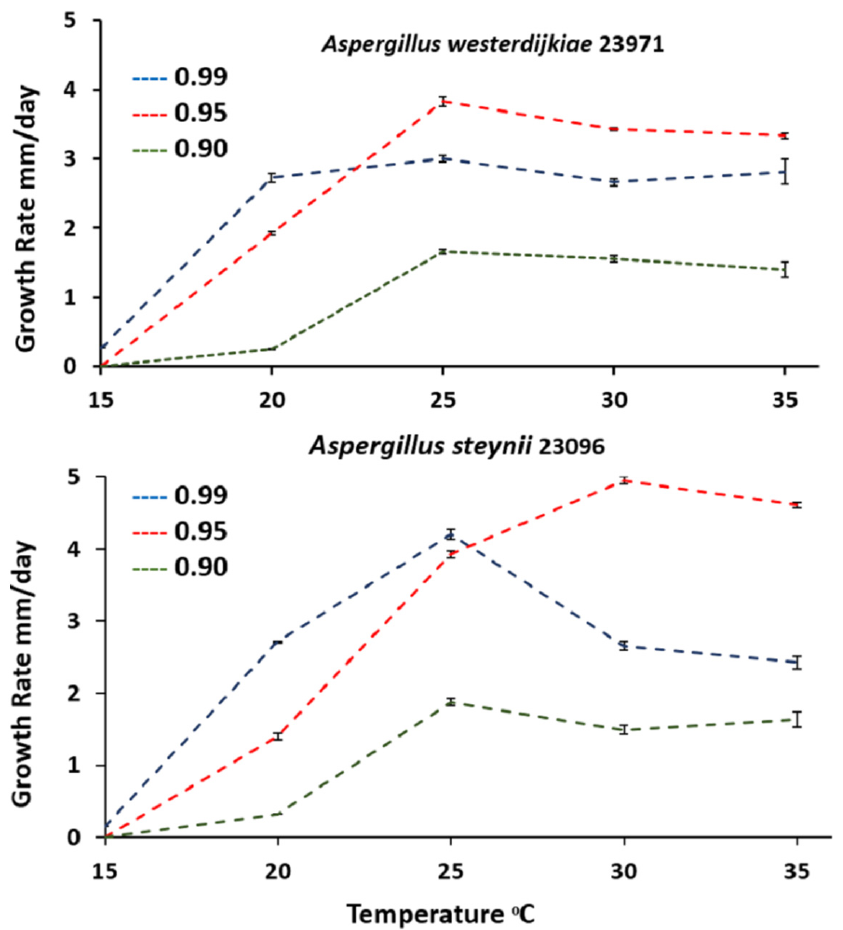
Figure 1. A. westerdijkiae IBT 23971 and A. steynii IBT 23096 growth rate in relation to temperature and water activity (a w ) in the YES medium. Vertical bars show standard errors for all strains.